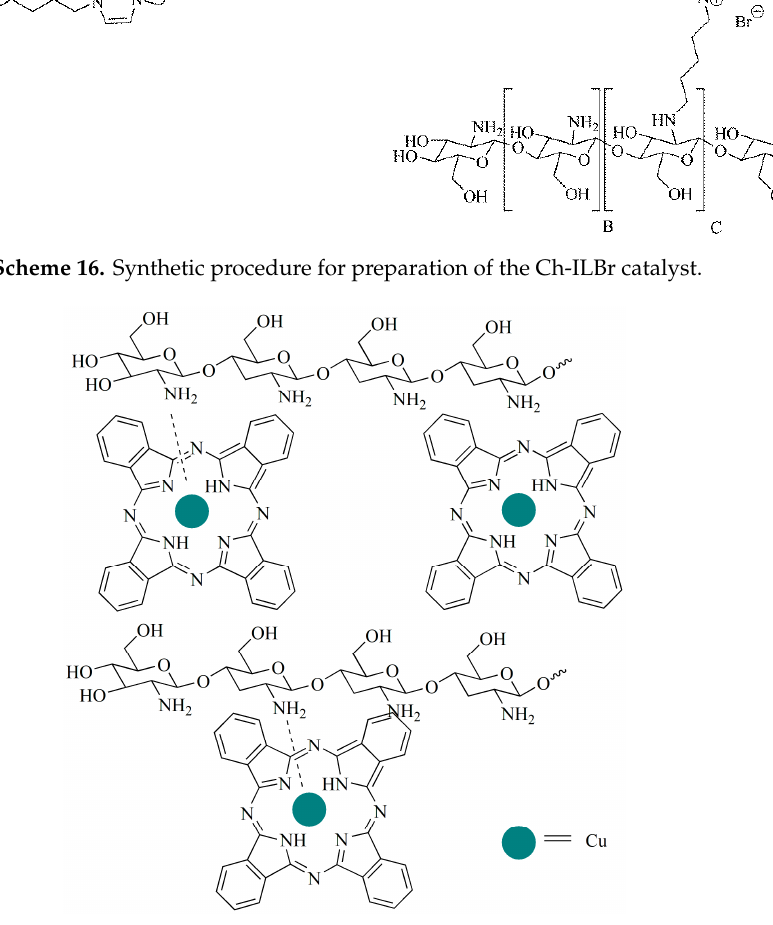
Scheme 17. Chemical structure of CuPc@CS.